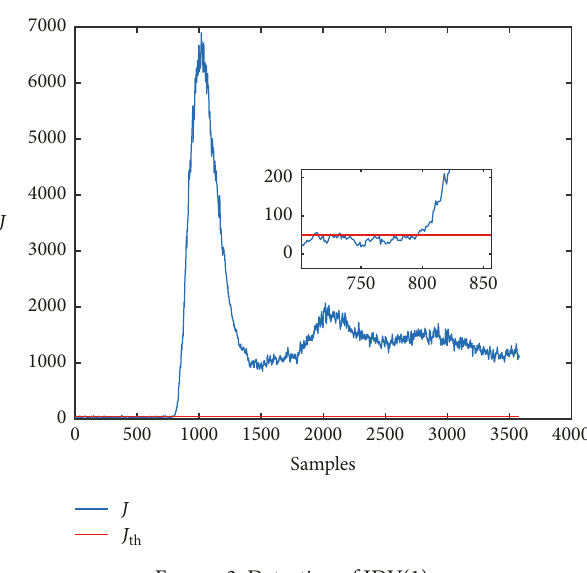
Figure 3: Detection of IDV (1)